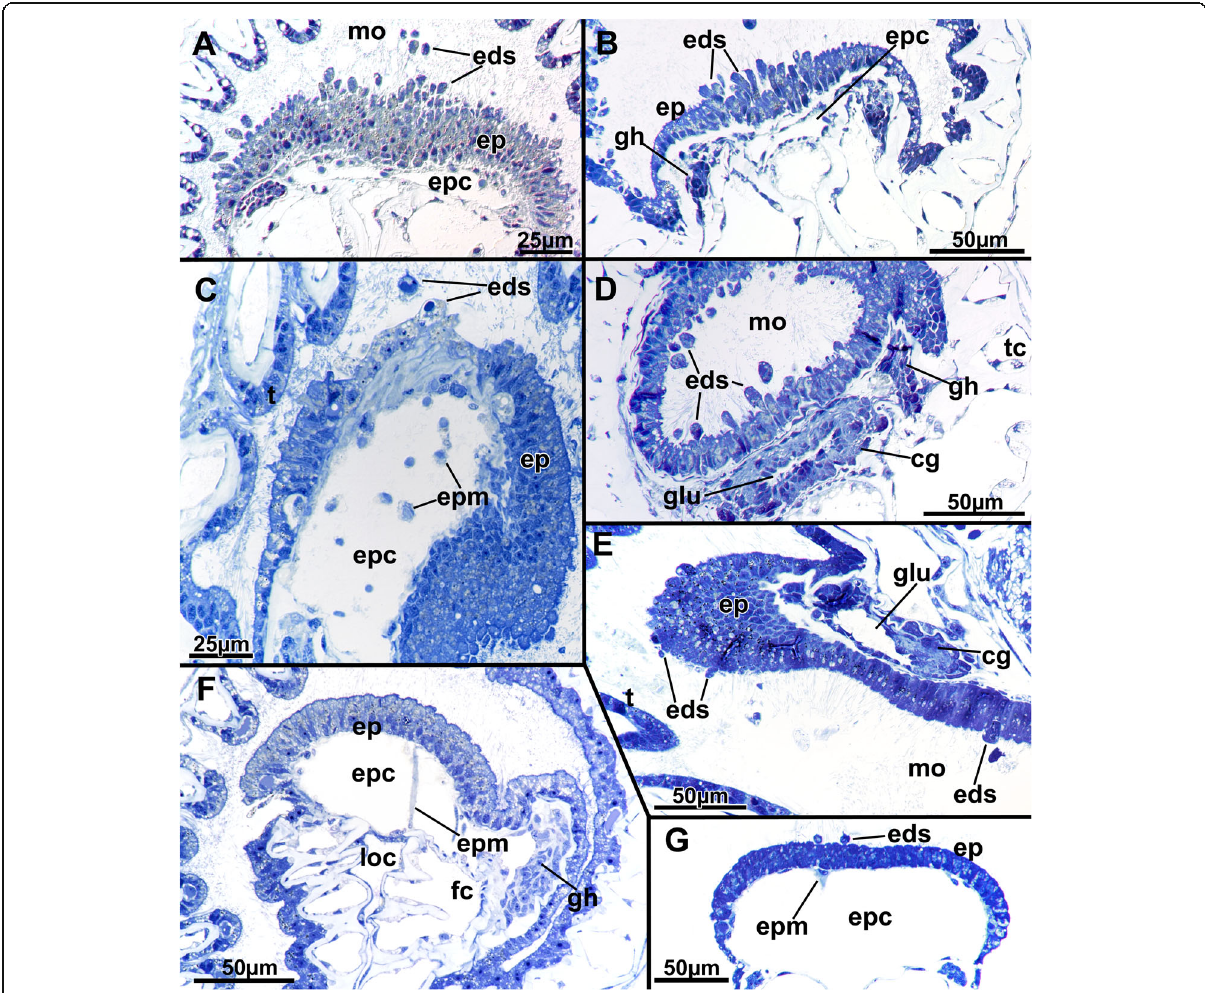
Fig. 7 Histological details of the epistome area of Stephanella hina . Semithin sections. All images are cross-sections (or slightly oblique) except E, which is a longitudinal image. With the exception of the latter, the epistomial epidermis always faces up towards the oral side of the animal and the anal side facing down. a The epistome epidermis is prominent and shows distinct epidermal secretions that ultimately enter the mouth area in the lophophoral base. b Less prominent epistome epidermis with fewer epidermal secretions. c An epistome epidermis with the median part apparently forming secretion droplets. Below that area, a conspicuous extracellular matrix seems to be present. d Section through the cerebral ganglion slightly below the epistome showing similar epidermal secretions occurring in the epidermal lining of the gut. e Longitudinal sections showing few secretion events in the epistome but synchronously in the foregut epithelium slightly below the cerebral ganglion. f An epistome showing prominent cells containing multiple inclusions but lacking any epidermal secretions. g Inconspicuous epistome with few,